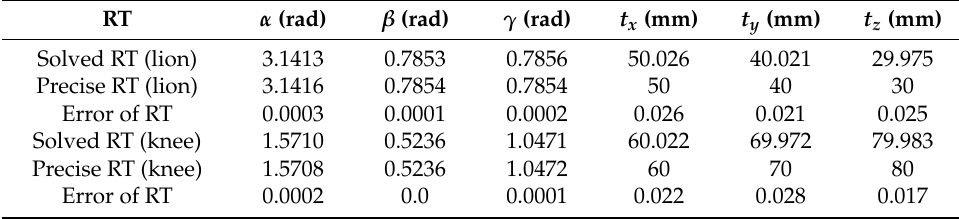
Table 2. Matching simulation results of knee bone model and Chinese lion